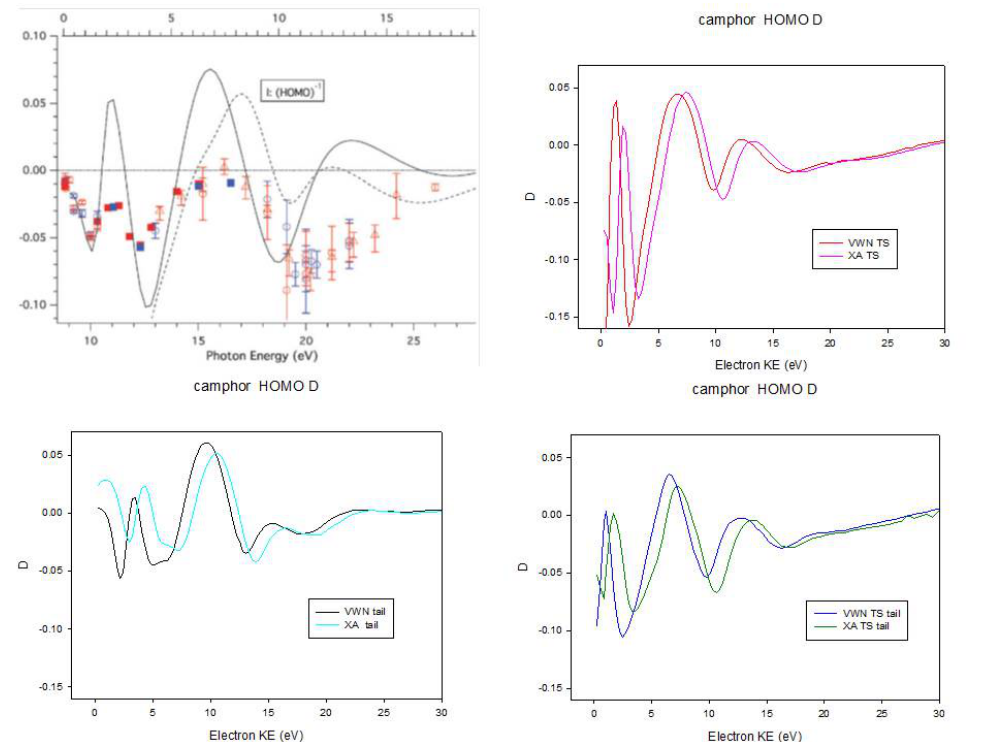
Figure 4. Dichroic parameter β 1 for Camphor HOMO ionization. Results for different potential choices. Left upper panel from ref. [49] with permission